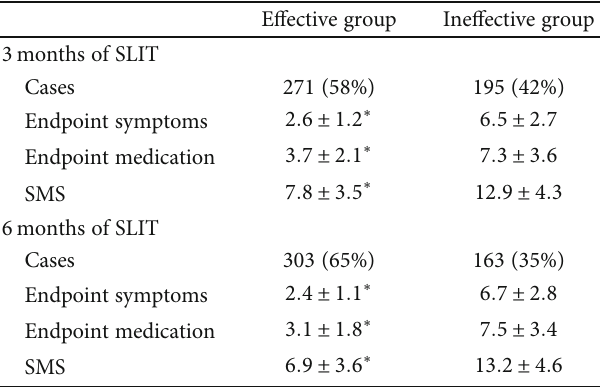
Table 4: Clinical e ffi cacy after short-term SLIT. E ff ective group Ine ff ective